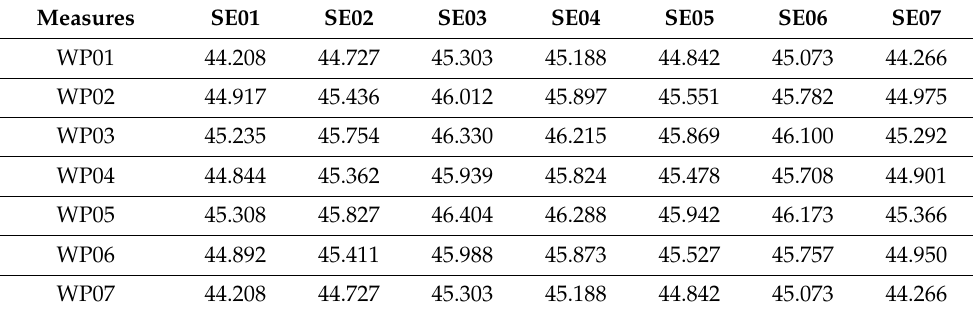
Table 6. Predicted SE Values from Combined SE and WP Measurements in Model 1.